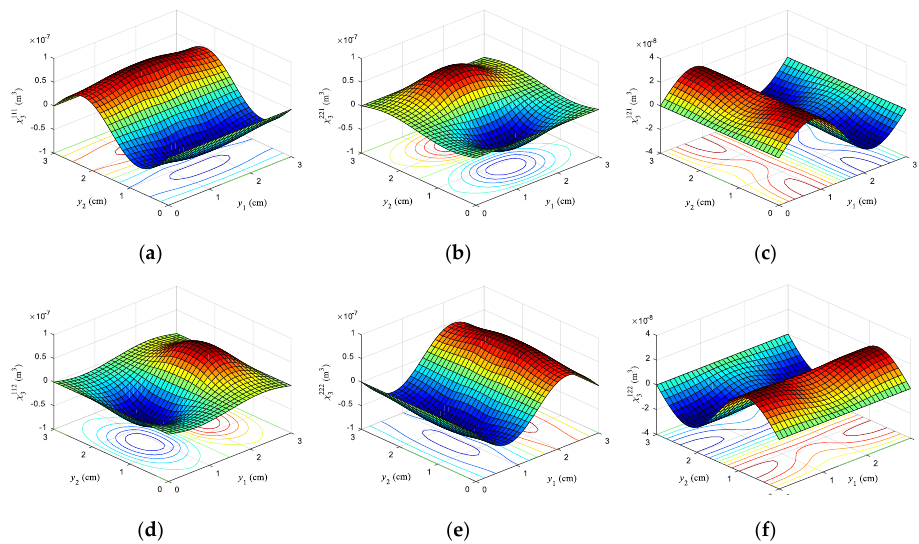
Figure 9. Second-order influence function 𝝌 2 of the CCCC single-layer periodic plate. ( a ) 𝑚𝑛 = 11 ; ( b ) 𝑚𝑛 = 22 ; ( c ) 𝑚𝑛 = 12.